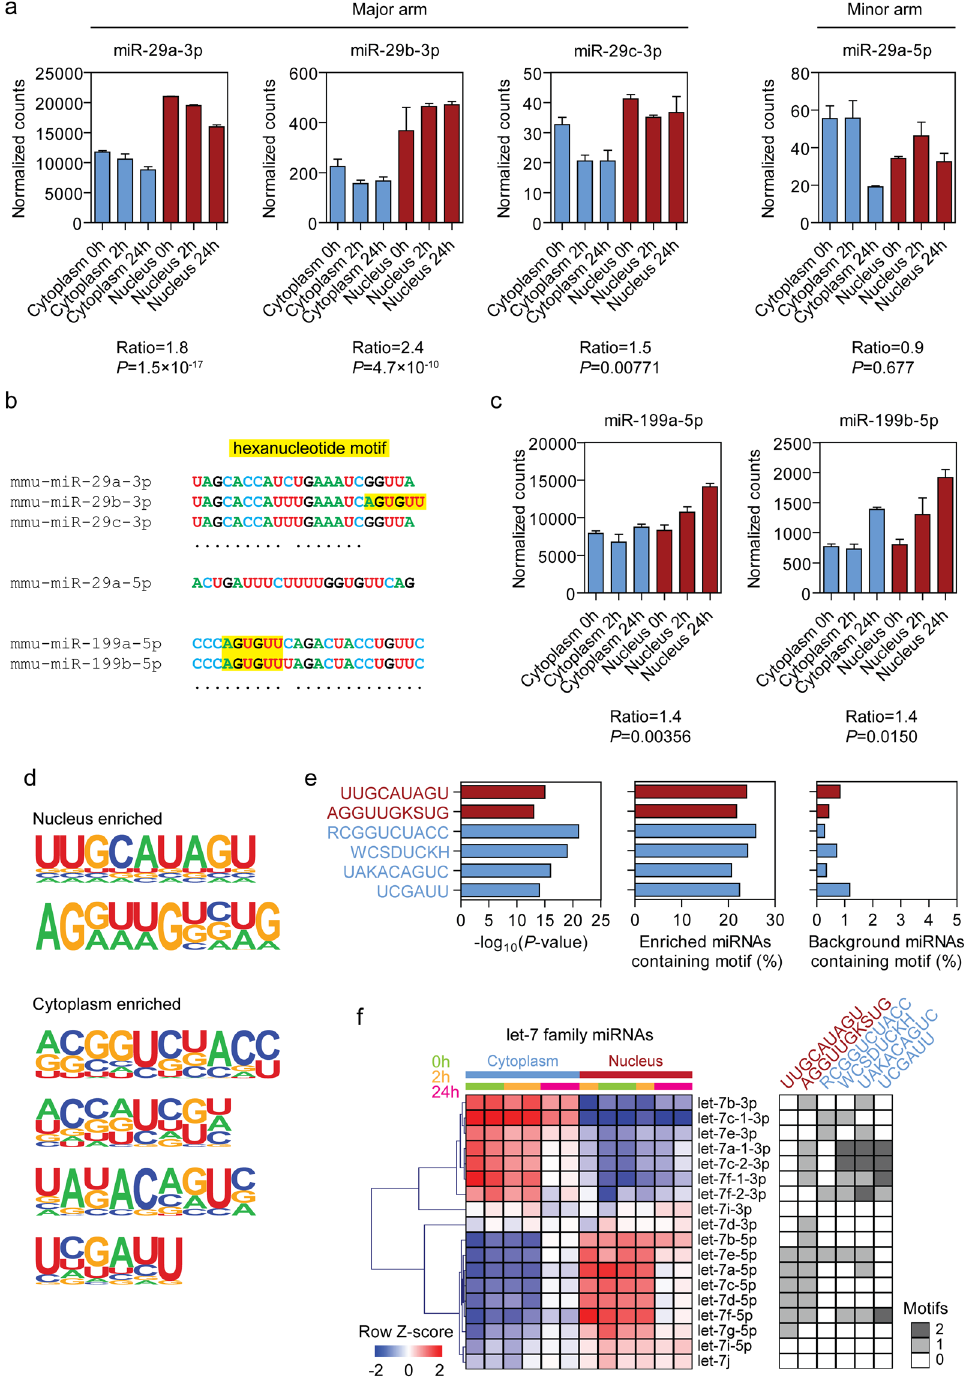
Figure 5. Analysis of putative miRNA sequence motifs affecting subcellular localization. ( a ) sRNA-seq normalized counts values for C166 nuclear and cytoplasmic fractions, with and without hypoxic stress, for the major arms of miR-29 family, and the minor arm of miR-29a-5p. ( b ) Alignments of all detected miR-29 miRNA family members, and miR-199a/b-5p. The positions of the 5 ʹ -AGUGUU-3 ʹ hexanucleotide motif are indicated in yellow. ( c ) Normalized sRNA-seq counts for miR-199a/b-5p. ( d ) Nuclear and cytoplasmic enrichment sequences identified by de novo motif enrichment. ( e ) Output statistics for de novo motif discovery; enrichment P -values, percentage of enriched miRNAs in containing each motif, and percentage of non-enriched miRNAs (i.e. background) containing each motif. (For ambiguous nucleotides; K = U or G, S = G or C, R = A or G, W = A or U, D = A, G, or U, and H = A, C, or U). ( f ) Heatmap of sRNA-seq data for let-7 family members. Scale bars show mean-centered log 2 normalized counts (row Z-score) where red and blue indicate higher and lower than mean abundance respectively. Occurrences of each enrichment motif in each family member are indicated in the greyscale heatmap. All values are mean ± SEM, n = 2